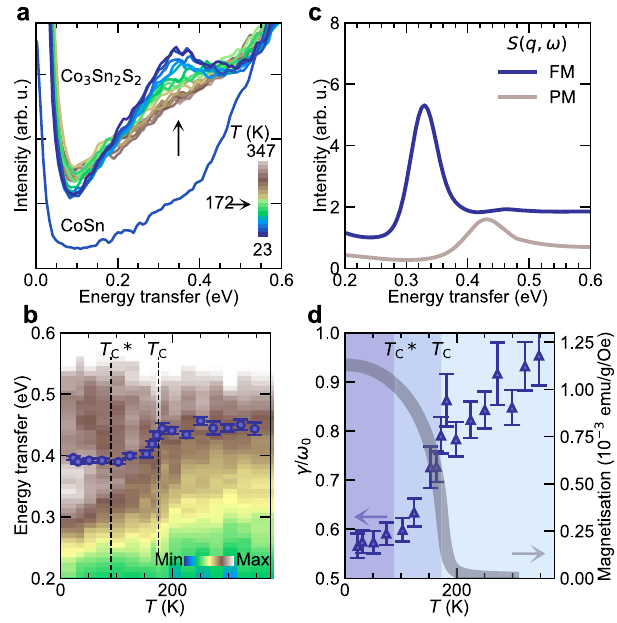
Fig. 4 | Temperature dependence of the fl at band Stoner excitations in Co 3 Sn 2 S 2 . Low-energy RIXS spectra at (0.025,1.25) at temperatures ranging from 23Kto347Kshownas( a )linesand( b )intensitymapforCo 3 Sn 2 S 2 .Alsocompared in ( a ) is the low-energy RIXS spectrafrom paramagnetic fl at band materialCoSnat ( − 0.15,0.5) collected at 20 K. The markers in ( b ) are the ω 0 values of S1 extracted from least-square fi ts of RIXS spectra. c Calculated S ( q , ω ) convoluted with the experimentalresolutionfortheFMandthePMbandcon fi gurationsat(0.025,1.25). d Extracted damping of S1 as a variation of temperature compared to the magne- tisation data of Co 3 Sn 2 S 2 . Shaded regions from 0 – 90 K, 90 – 175 K and 175 – 350 K represent c -axis FM, c -axis FM with ab -plane antiferromagnetic, and the PM mag- netisationvolume,respectively,inCo 3 Sn 2 S 2 underzero-applied- fi eldfromRef.[19] Error bars are least-square- fi t